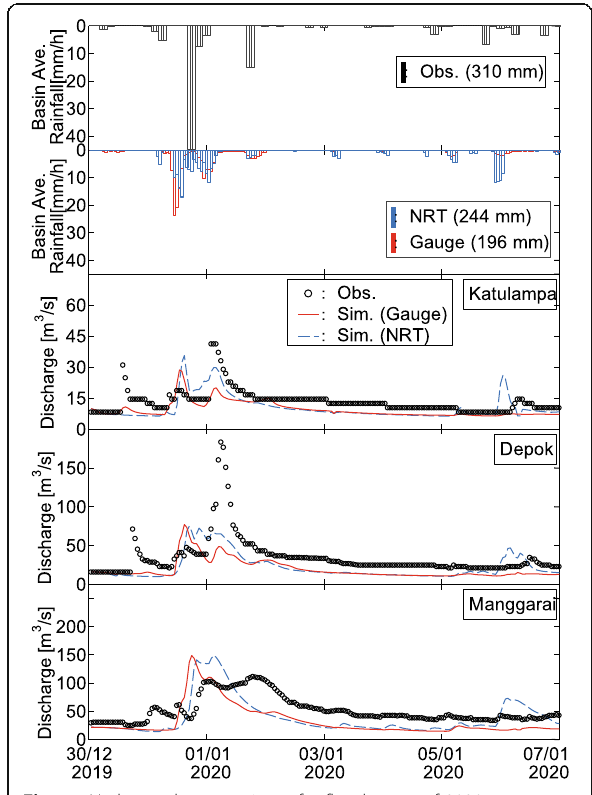
Fig. 11 Hydrograph comparisons for flood event of